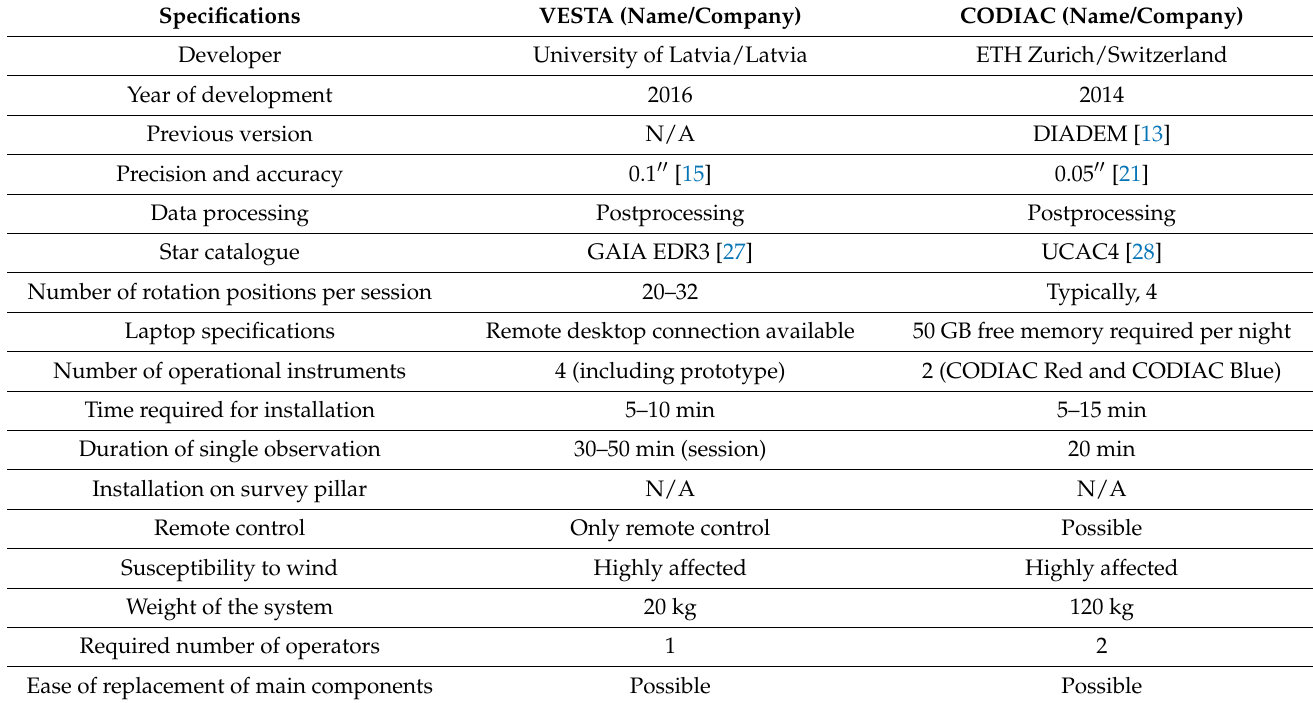
Table 2. Selected specifications of VESTA and